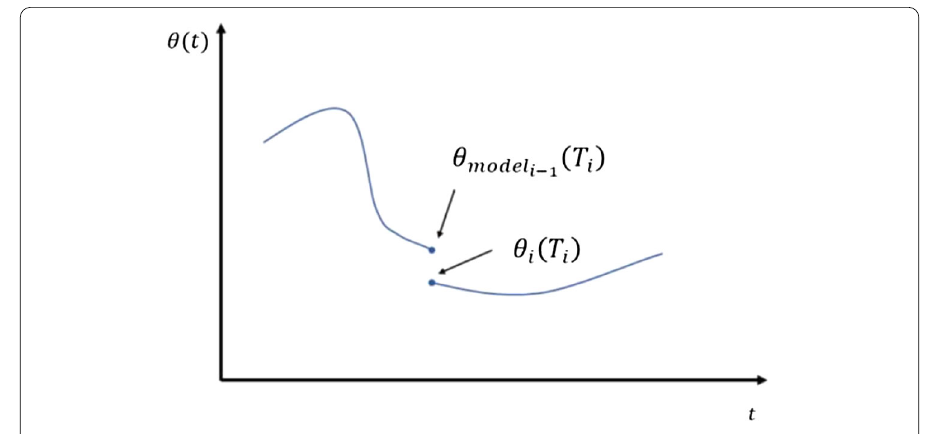
Figure 1 The discontinuity of θ ( t ) at the joins